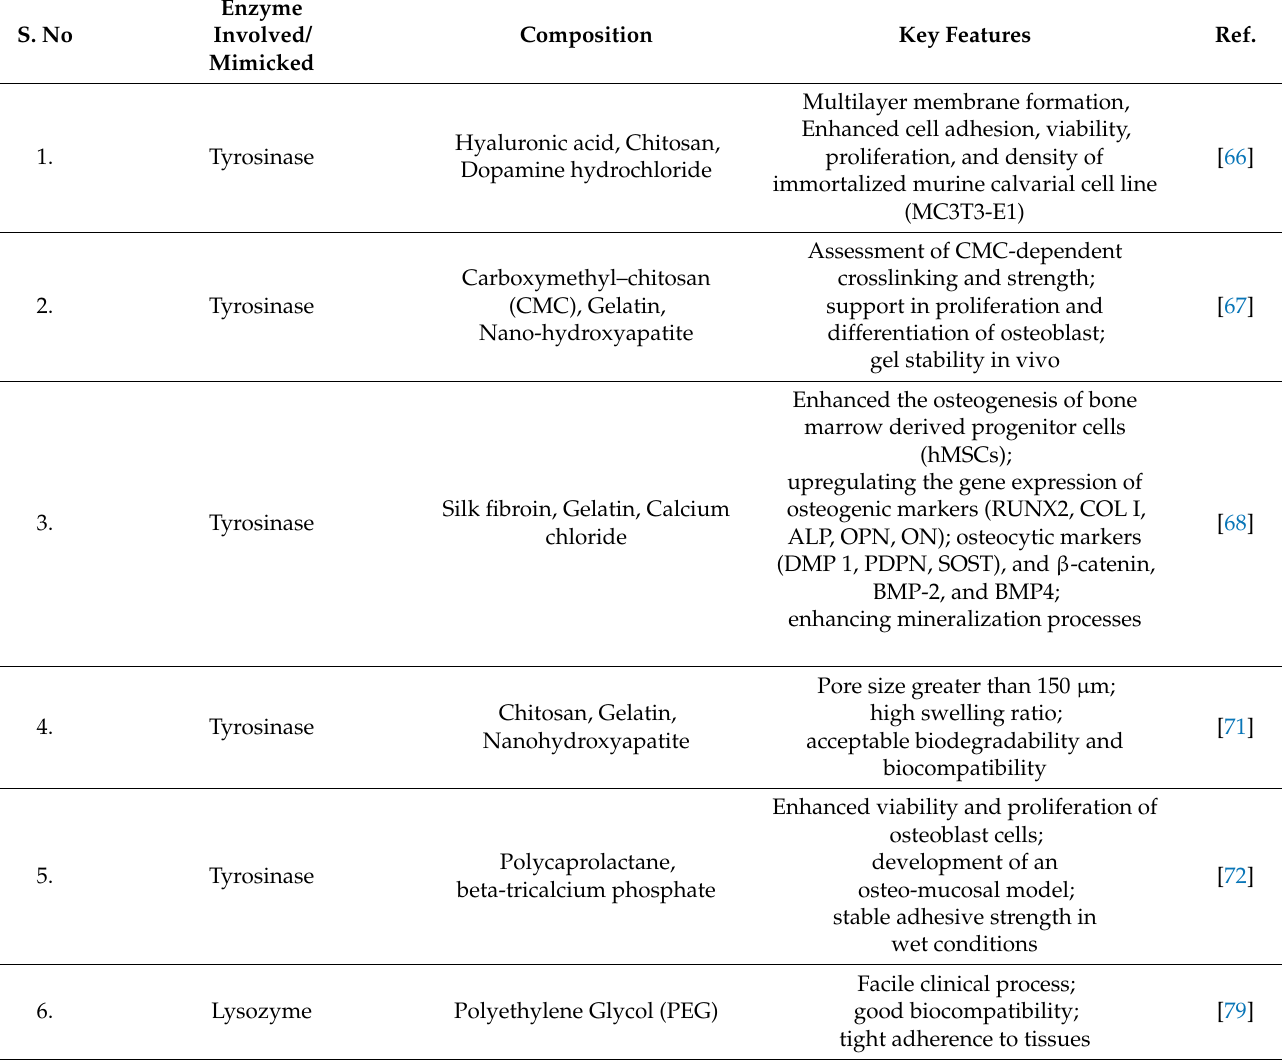
Table 2. Summary of different studies on enzyme-mediated crosslinking hydrogels for bone tissue